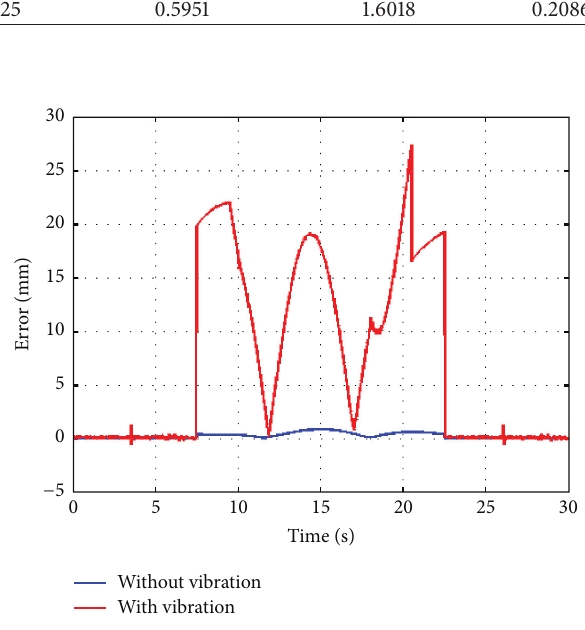
Figure 13: Error present on the estimation of the rectangular path. Figure 14: Error present on the estimation of the circular